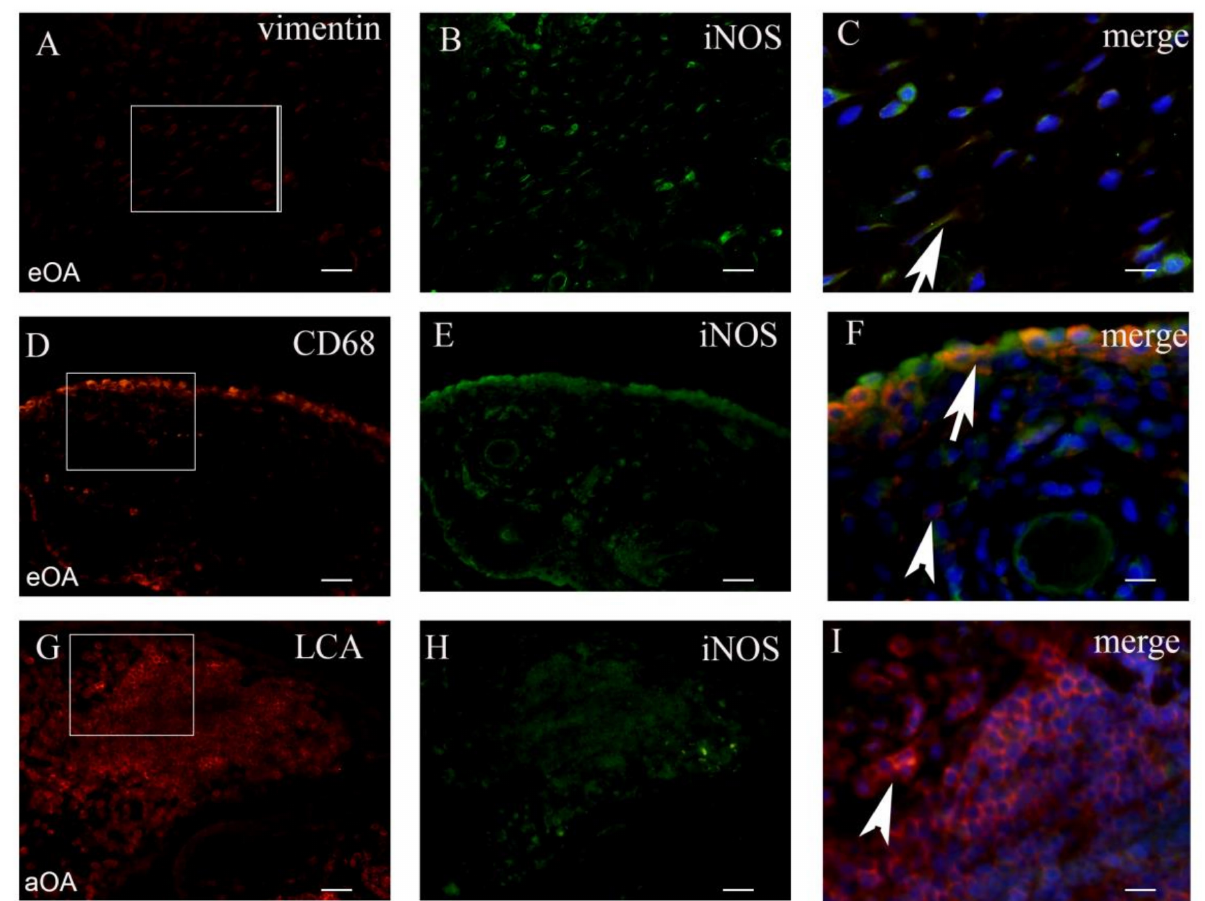
Figure 4. The synovial membrane of patients with early OA (eOA) ( A – C ). Vimentin positive (red) fibroblasts in the subintima (frame). iNOS positive cells (green) in the synovial intima and subintima ( B ). The merge of DAPI (blue) nuclear stain+vimentin+iNOS (magnification of frame in panel A ) show occasional fibroblasts in the subintima co-localized with iNOS and vimentin (arrow) ( C ). The synovial membrane of patients with early OA (eOA) ( D – F ). CD68 positive (red) macrophages in the intima and subintima (frame). iNOS positive cells (green) in the synovial intima and subintima ( E ). The merge of DAPI (blue)+CD68+iNOS (magnification of the frame in panel ( D )) show numerous macrophages in the intima co-localized with iNOS and CD68 (arrow), while the subintima displayed CD68 positive macrophages(arrowhead) ( F ). The synovial membrane of patients with advanced OA (aOA) ( G – I ). LCA positive (red) lymphocytes in the intima, subintima, and lymph nodule (frame). iNOS positive cells (green) in the synovial intima and subintima ( H ). The merge of DAPI (blue)+LCA+iNOS (magnification of the frame in panel ( G )) show no co-localization of iNOS and LCA, while a numerous number of lymphocytes display only LCA (arrowhead) ( I ). Magnification × 40 (first two columns), scale bar 25 µ m and × 100 (last column), scale bar 10 µ